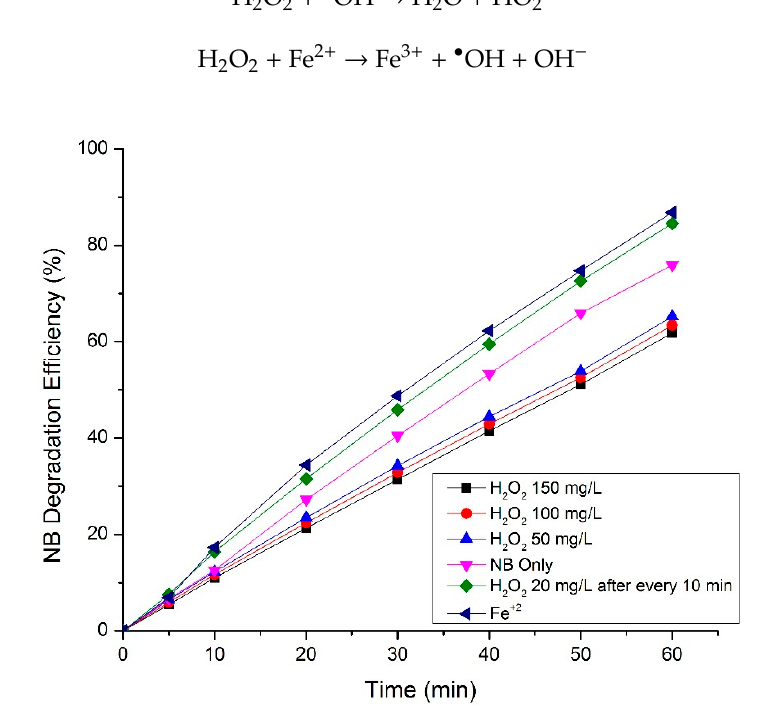
Figure 8. The effect of the addition of different promotor on the degradation of NB, at an NB concentration of 20 mg / L, an oxygen flow rate of 3 L / min, and an applied voltage of 1.8 concentration of 20 mg/L, an oxygen flow rate of 3 L/min, and an applied voltage of 1.8 kV.